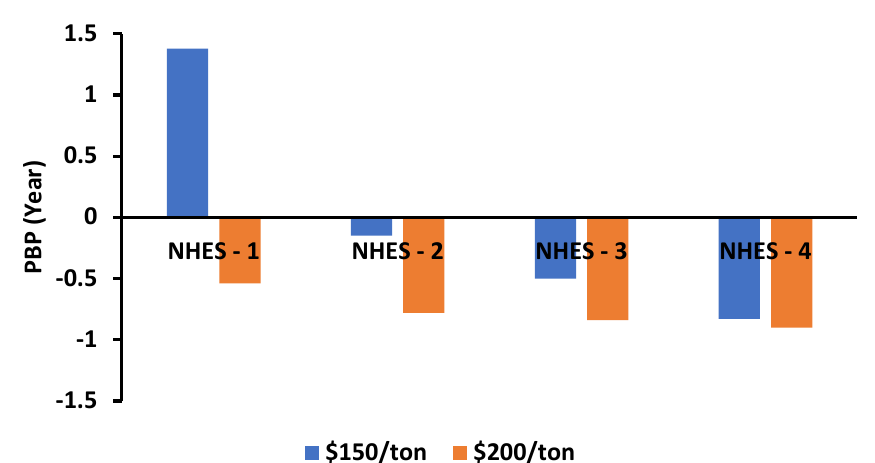
Figure 19. Difference in PBP based on increased carbon tax for California region .